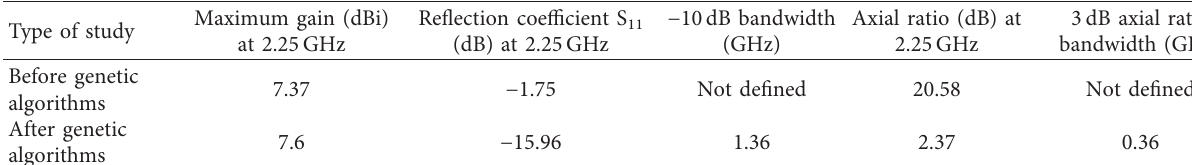
Table 4: Simulation results at 2.25GHz before and after optimization.